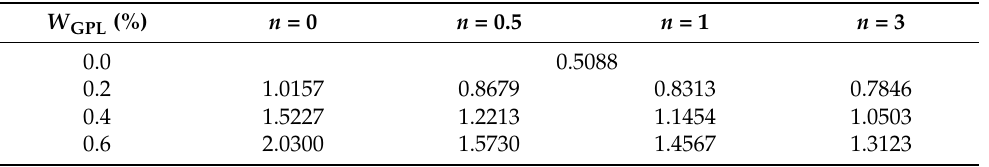
Table 1. Buckling loads of the FG-GPLRC arch having different weight fractions of distributed graphene platelets (GPLs).